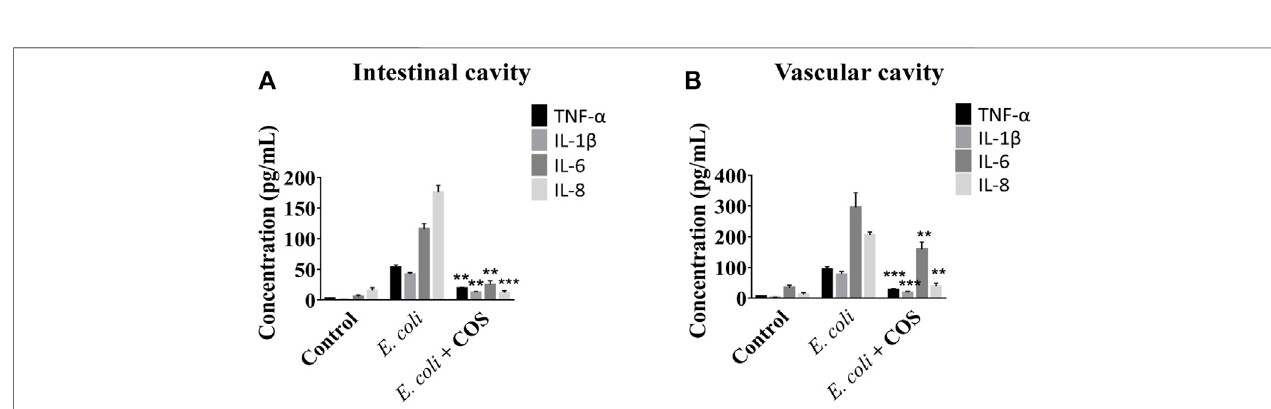
FIGURE 5 | COS reduced in fl ammation caused by E. coli 11775. The concentrations of in fl ammatory factors in the out fl ow solution from intestinal cavity (A) or vascular cavity (B) on the chip. Data were represented as mean ± SD ( n = 3); E. coli vs. E. coli + COS group, One-way ANOVA test was performed, ** p < 0.01, *** p <